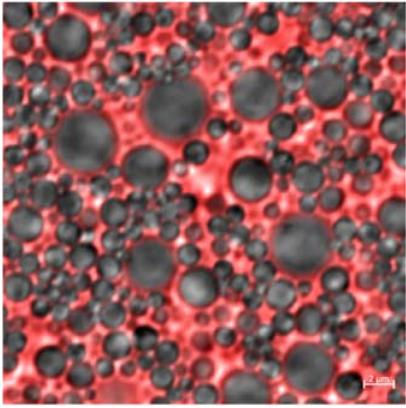
Figure 1: Confocal micrograph of HIPE - Gly10. Monomers ( contin - uous phase ) were marked with fl uorescent dye rhodamine B.